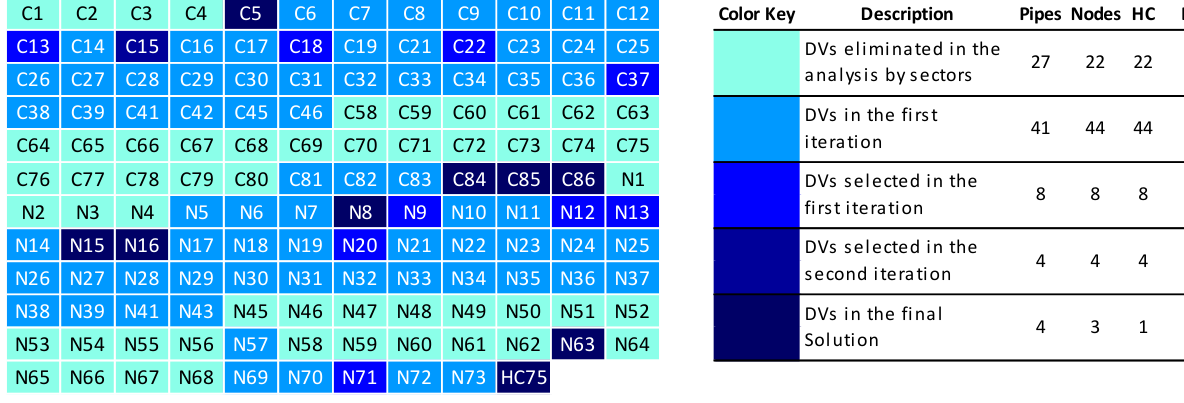
Figure 11. SSR in Balloon network. Table 2. Results of the final optimization in the Balloon network.